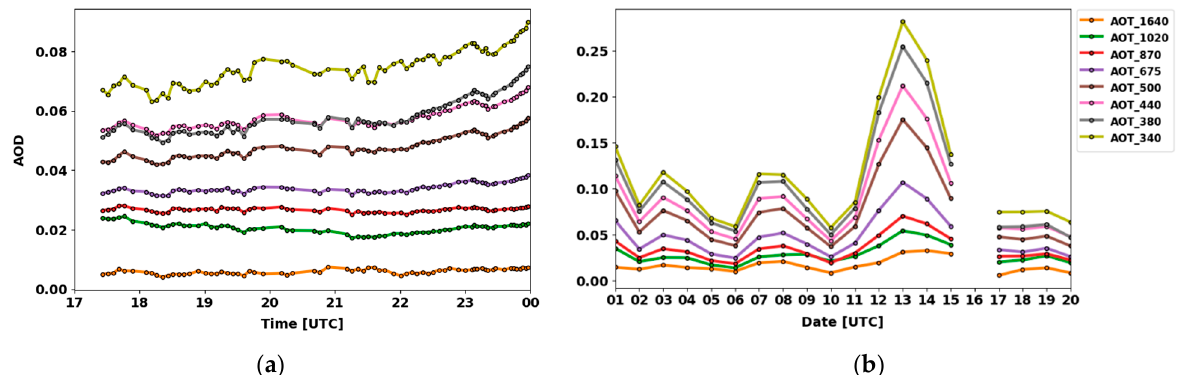
Figure 2. ( a ) Time series of spectral AOD measurements (AERONET Level 1.5) at the UNR site (39.541 ◦ N, 119.814 ◦ W) on 17 October 2019 (left); ( b ) Time series of spectral AOD measurements at the UNR site during 2019 October at wavelengths from 340 nm to 1640 nm